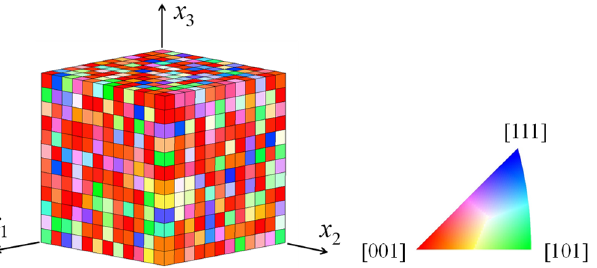
Figure 4. Polycrystal aggregate model consisting of 1728 elements. One element represents one grain.